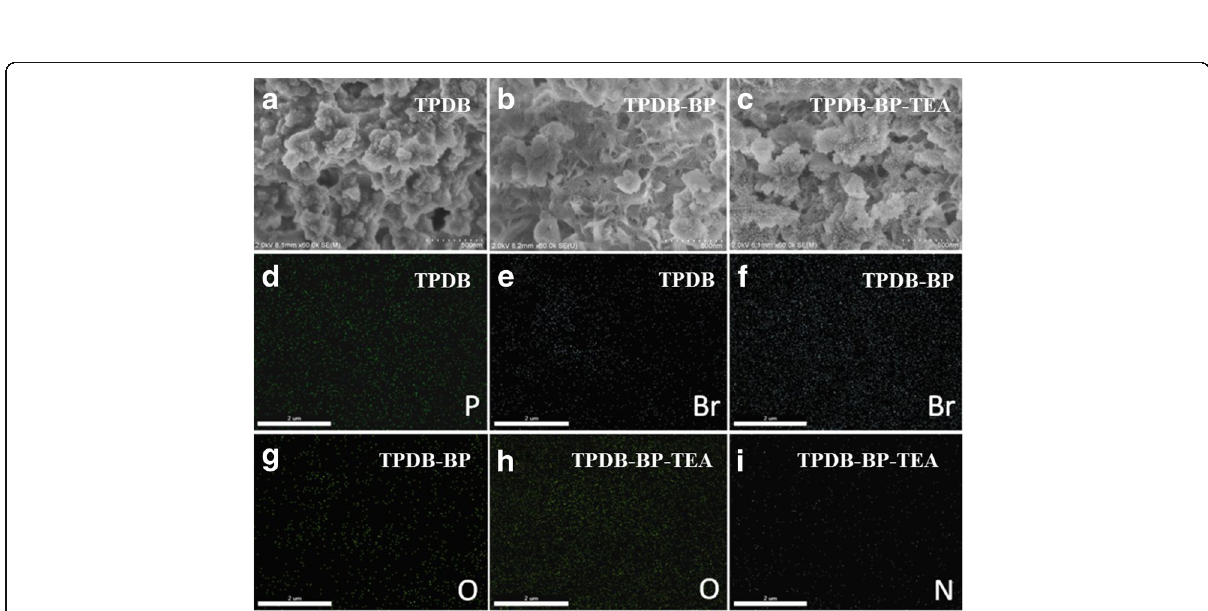
Fig. 3 a Wide XPS spectrum, b Br spectrum, c N spectrum, and d P spectrum of TPDB-BP-TEA. The wide XPS spectra in Fig. 3 indicate the presence of P, C, N, Br, and O elements on TPDB-BP-TEA